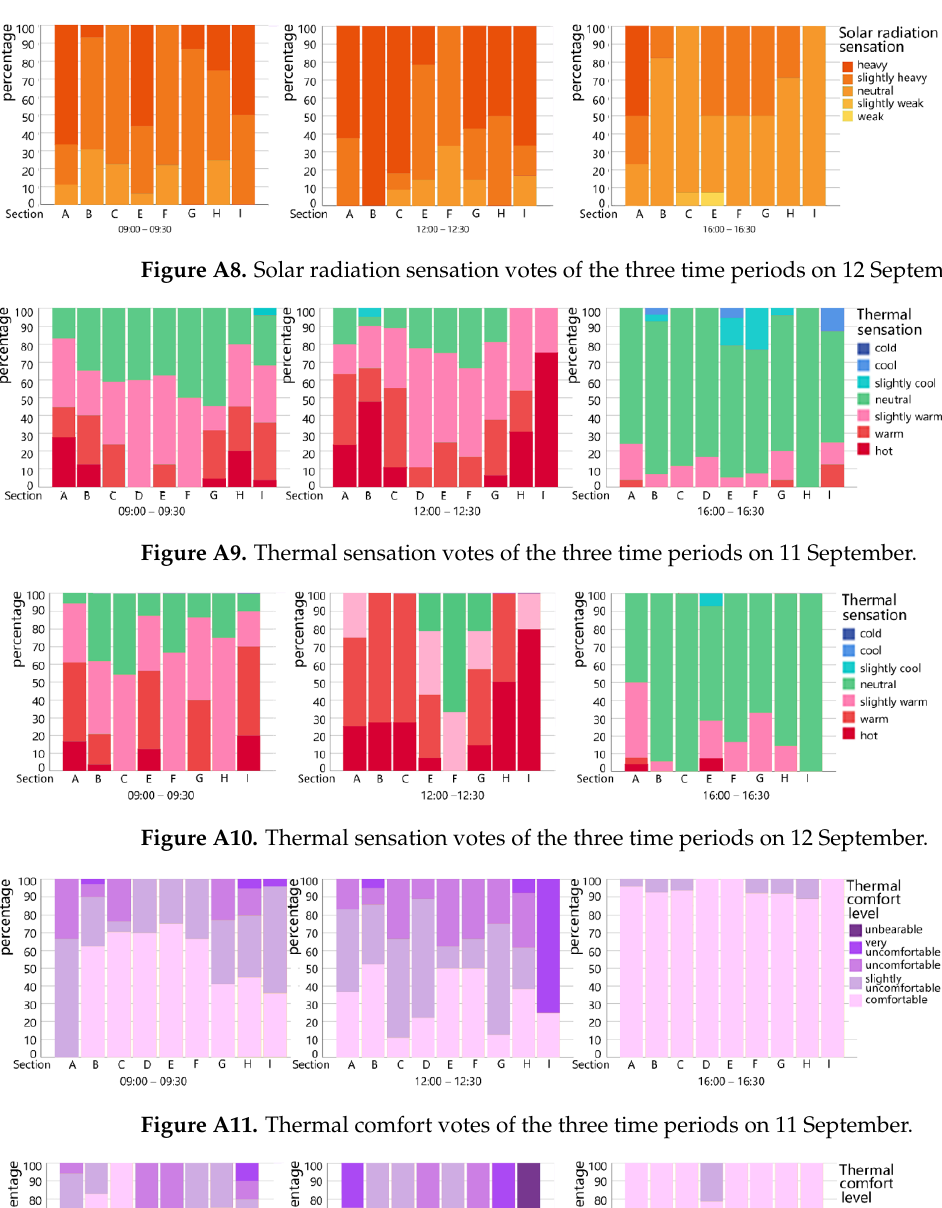
Figure A7. Solar radiation sensation votes of the three time periods on 11 September.